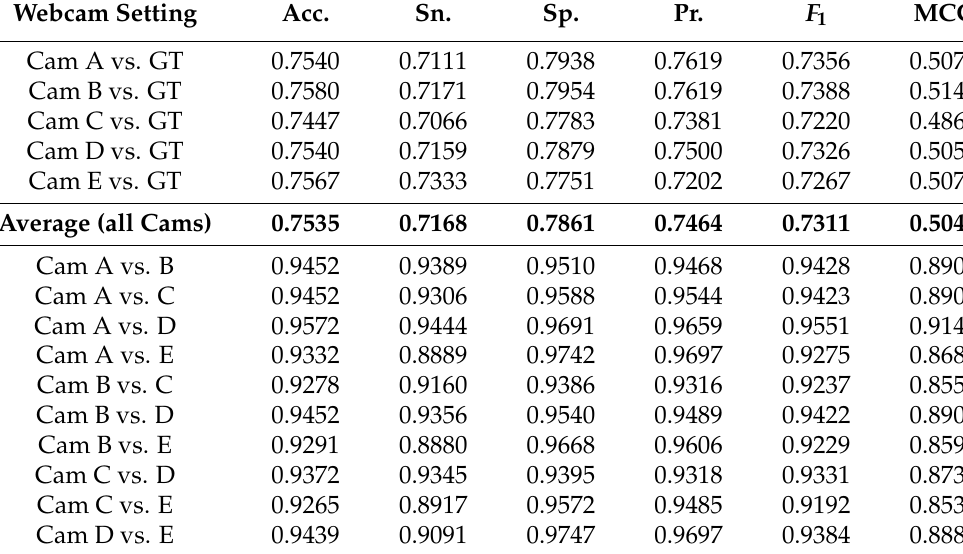
Table 6. Performance evaluation of proposed system for eye shape attributes detection. Acc.: accuracy, Sn.: Sensitivity, Sp.: Specificity, Pr.: Precision, F 1 : F 1 score, MCC: Matthews Correlation Coefficient, GT: Ground